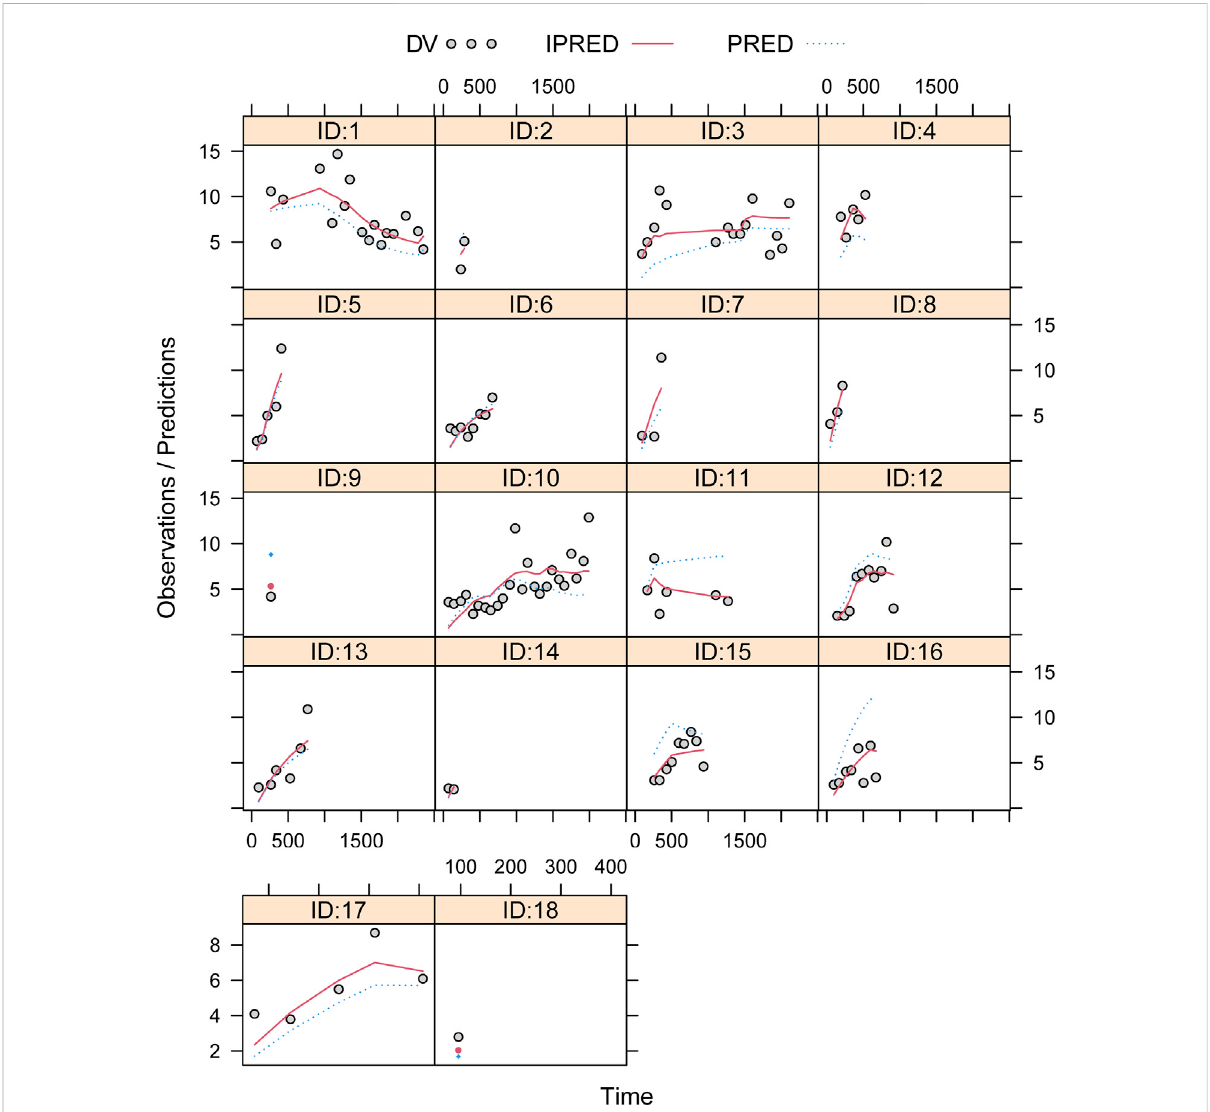
FIGURE 2 Individualplots.ID,patientIDnumber;DV,measuredconcentrationvalue;IPRED,individualpredictivevalue;PRED,populationpredictivevalue.